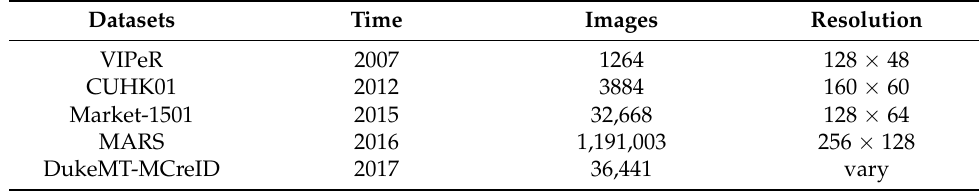
Table 1. Image resolution of common data sets for person